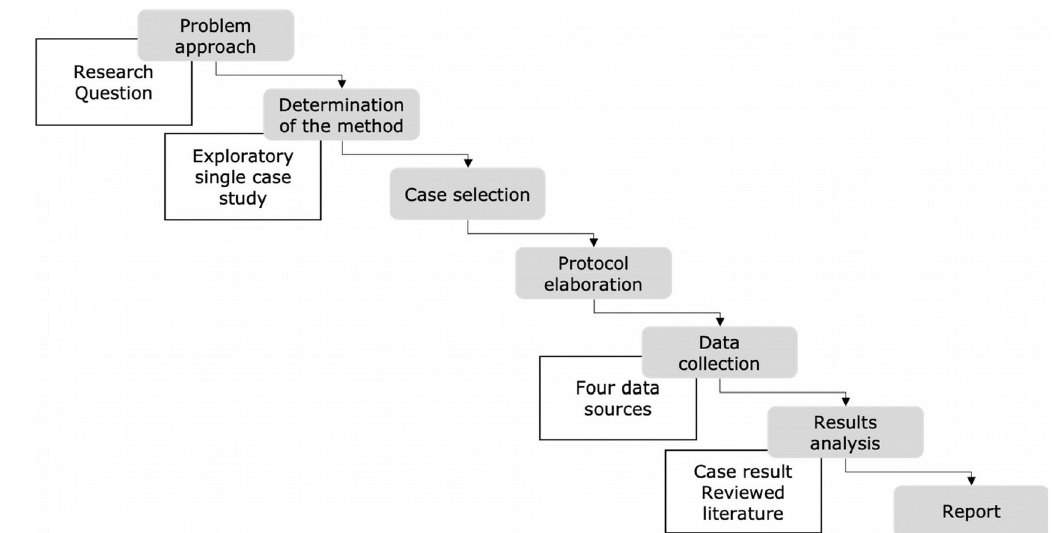
Figure 1. Methodological procedure followed in this